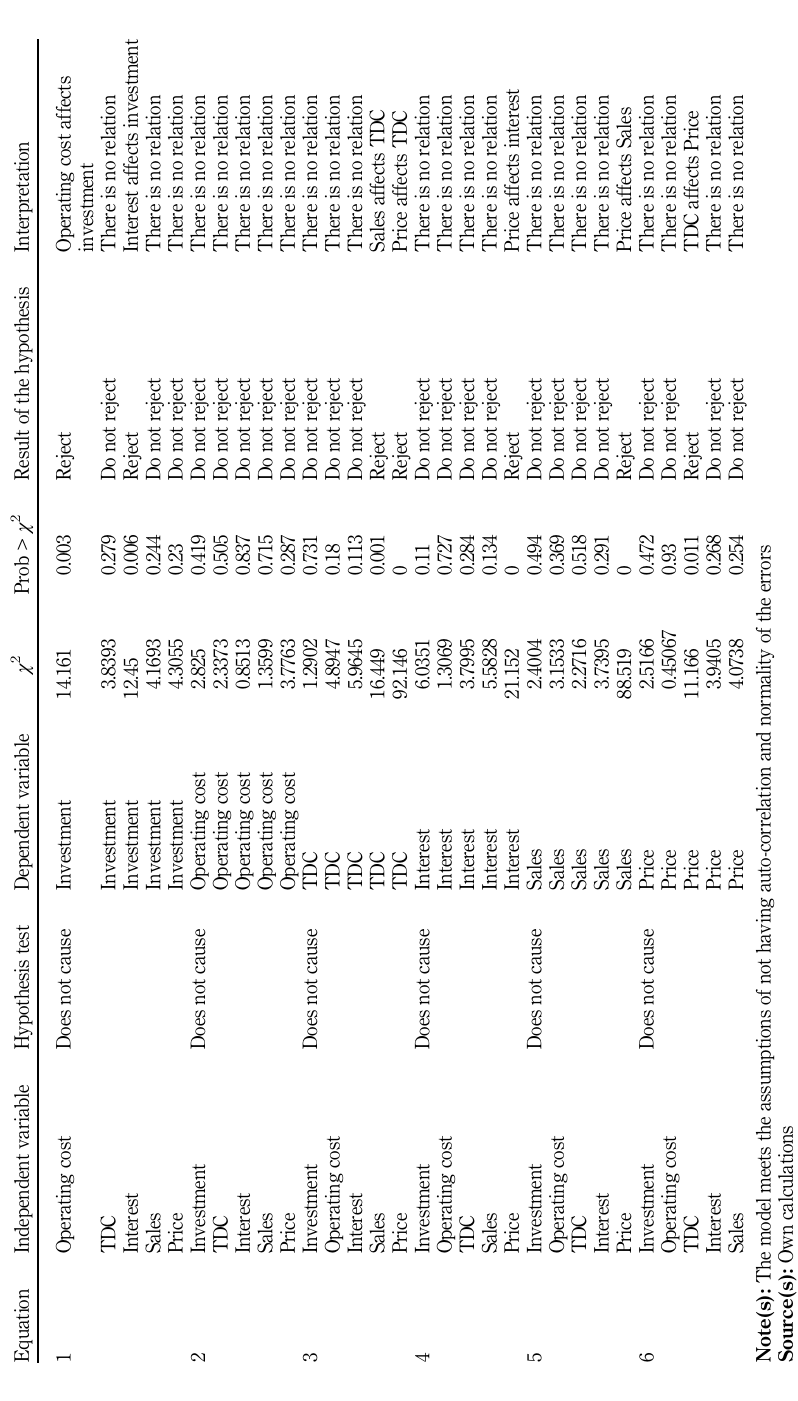
Table 7. Granger causality